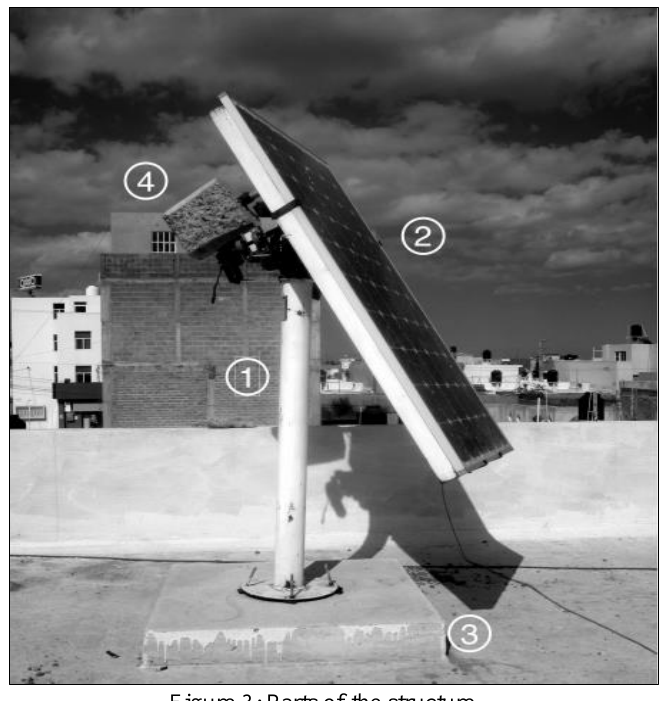
Figure 3: Parts of the structure.